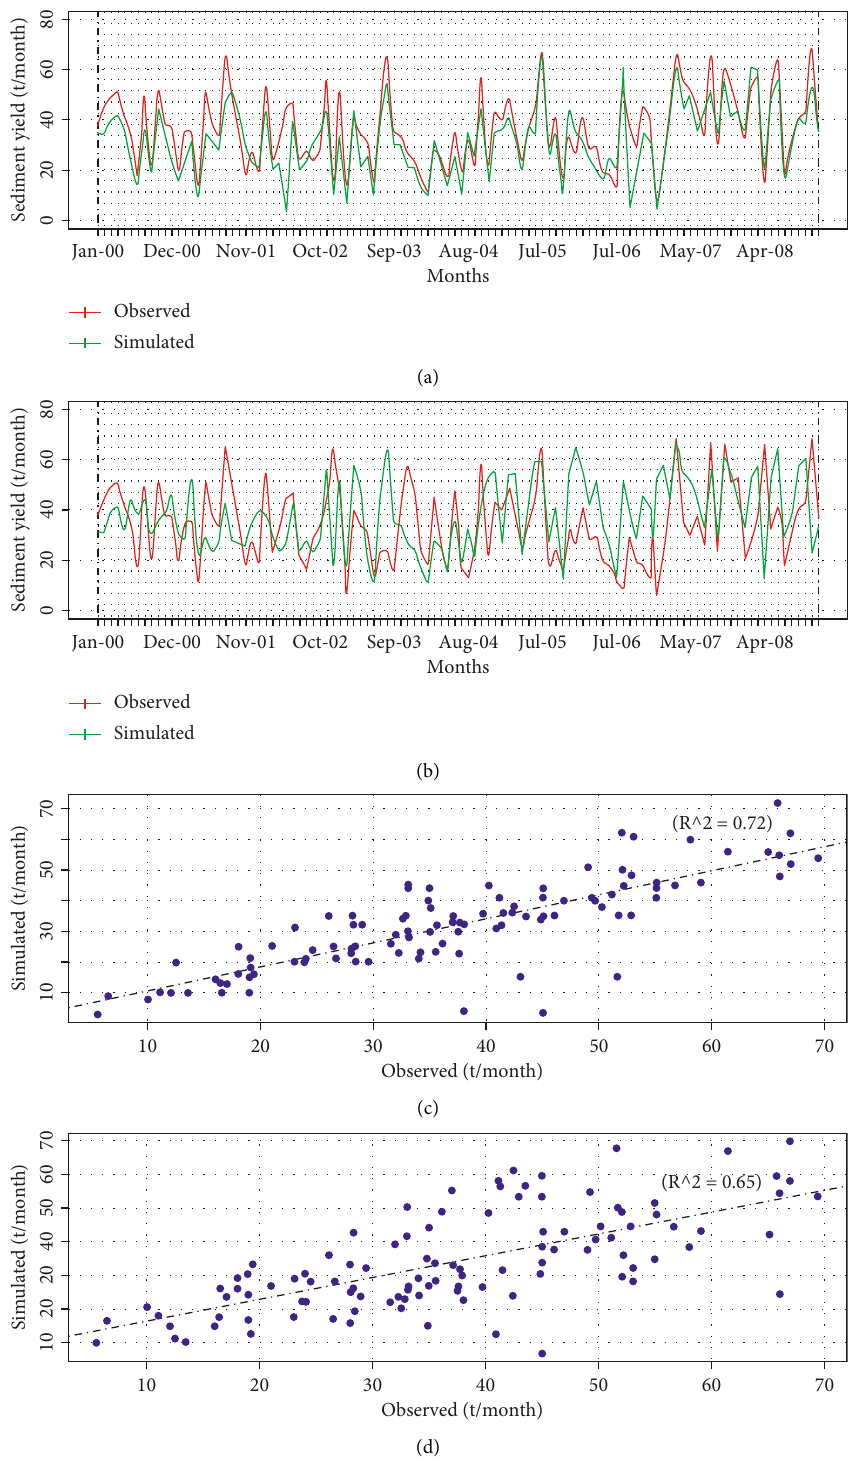
Figure 6: Sediment calibration with (a) RACMO22T and (b) RCA4 models and validation on (c) and